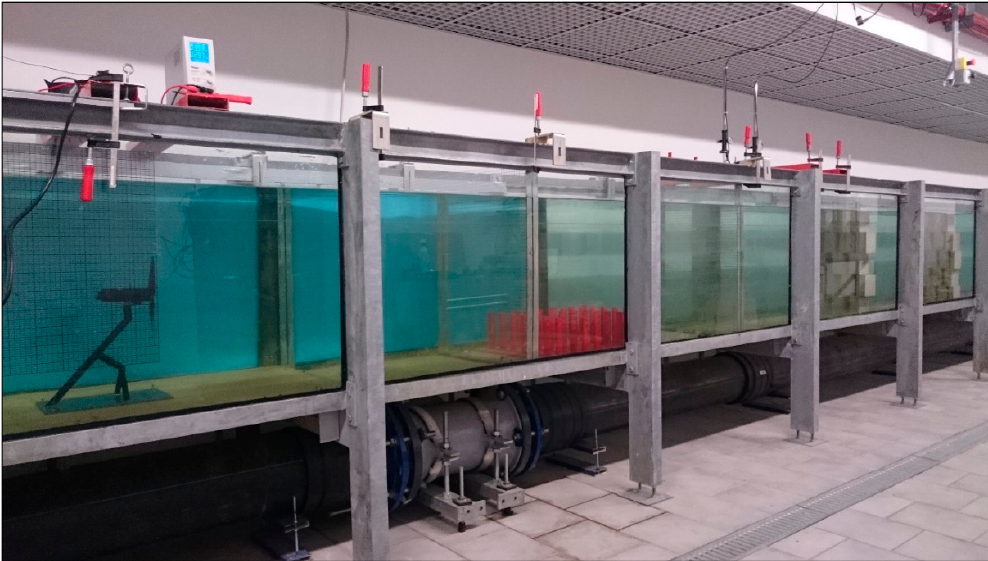
Figure 17. Central section of water channel with turbulence-generating structures, turbine and support structure, and all measurement equipment in place.